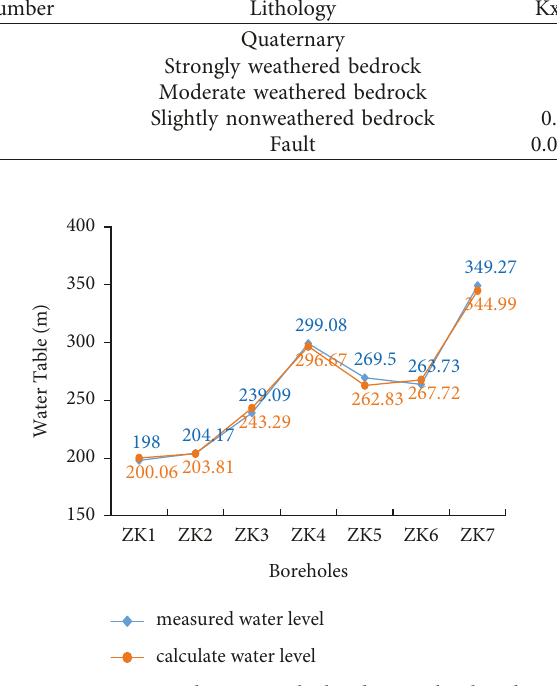
Figure 5: Comparison between calculated water level and mea- sured water level.